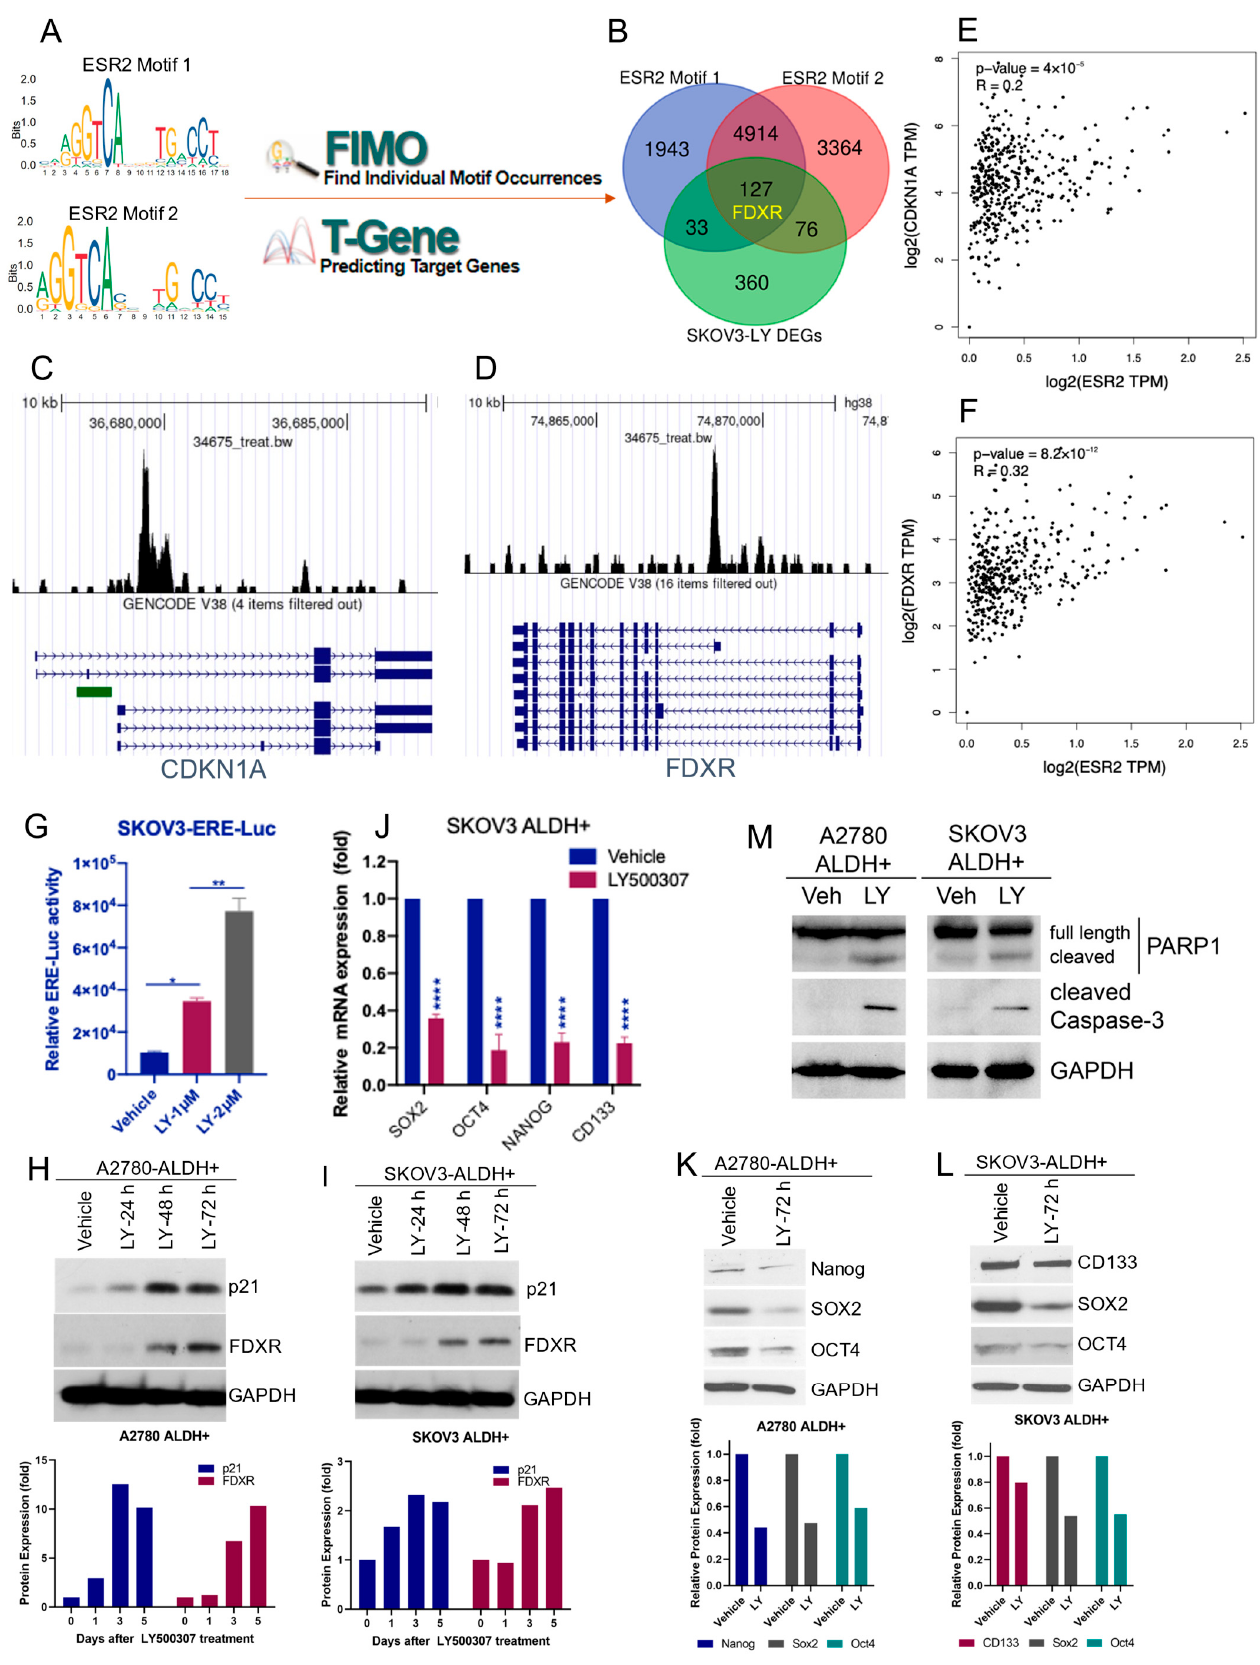
Figure 4. In silico analysis suggested FDXR and CDKN1A could be direct targets of ER β . ( A ) Exploration of potential ER β target genes. Motifs of ESR2 (ER β ) were acquired from JASPAR